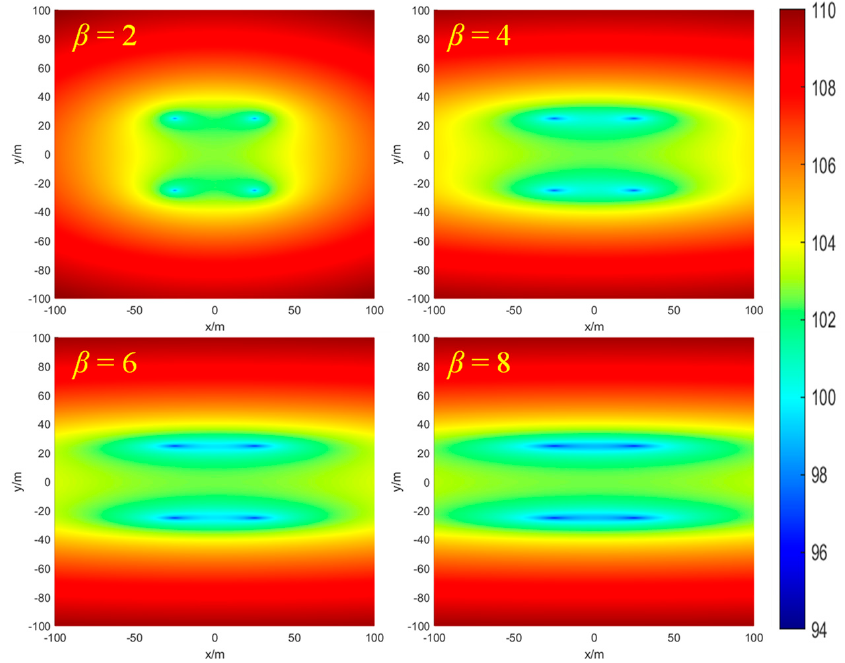
Figure 12. Distribution of pressure field of coal seam under homogeneous state without fracturing.